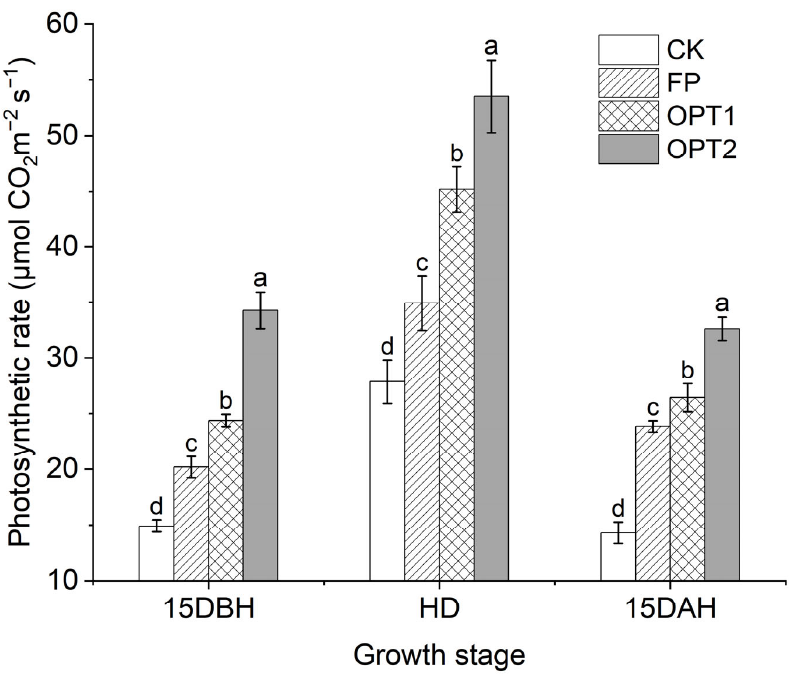
and all showed OPT2 > OPT1 > FP > CK (Figure 3). Among them, OPT2 at HD had the highest mean P N of 53.5 μ mol m − 2 s − 1 , which was 92%, 53%, and 19% higher than that of CK, FP, and OPT1, respectively.